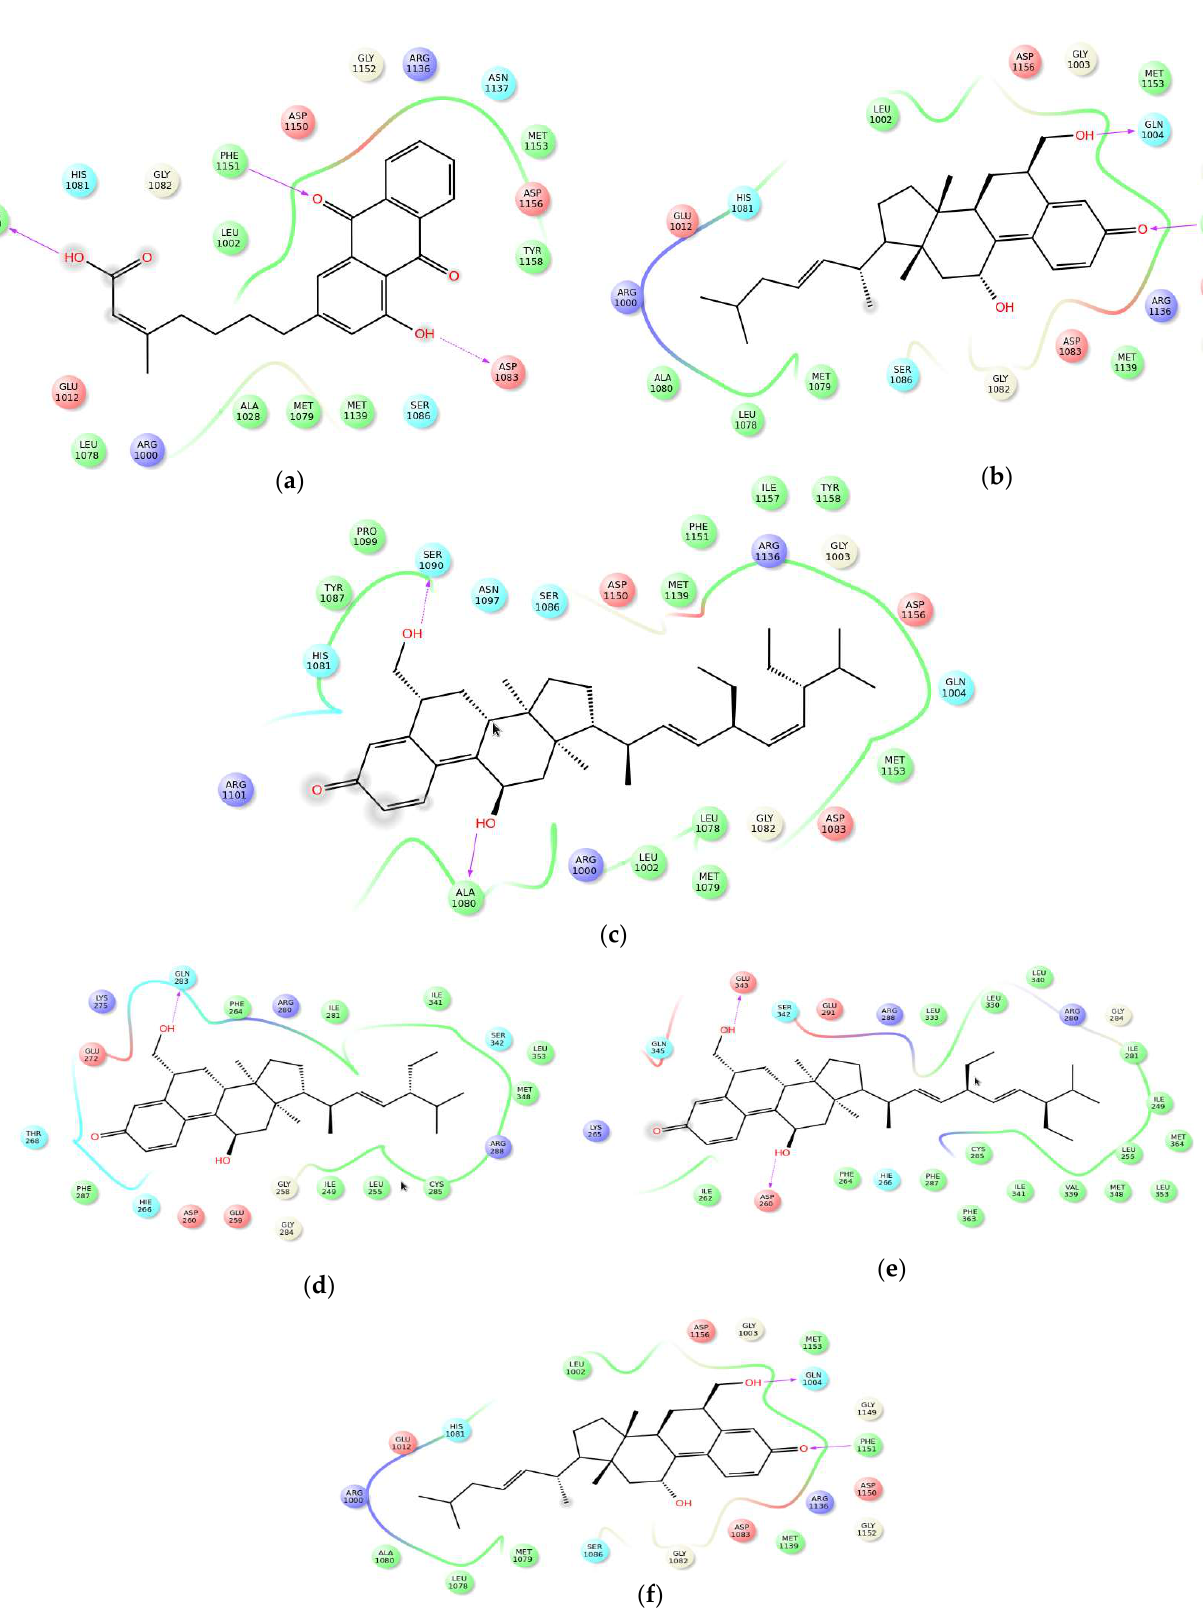
Figure 11. Molecular interaction poses of the 3 compounds with IRK and PPAR- γ : ( a ) the interaction between IRK and compound 1 ; ( b ) the interaction between IRK and compound 2 ; ( c ) the interaction between IRK and compound 3 ; ( d ) the interaction between PPAR- γ and compound 1 ; ( e ) the interaction between PPAR- γ and compound 2 ; ( f ) the interaction between PPAR- γ and compound 3 .